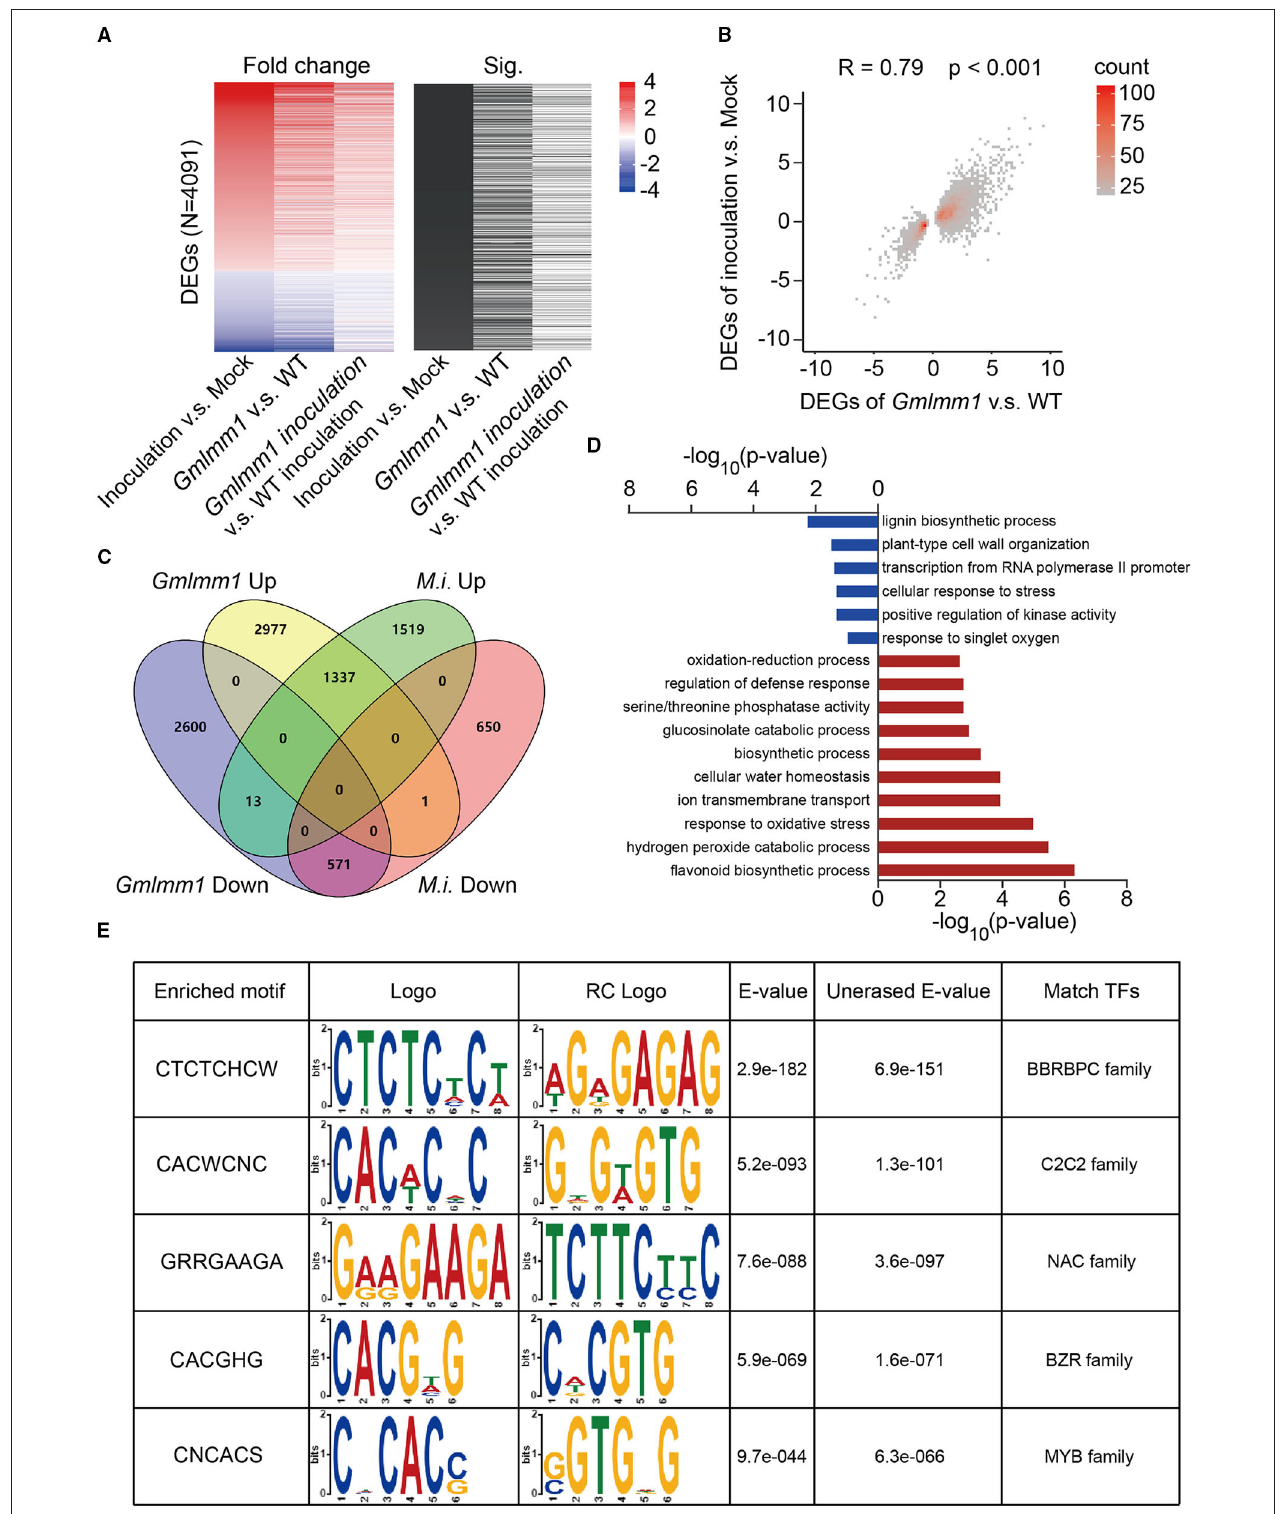
FIGURE 3 | RNA-seq assay identifies GmLMM1 -regulated genes in defense response against M. incognita . (A) Heatmap of fold changes in DEGs following M. incognita inoculation ( n = 3) or GmLMM1 mutation or the combination of both. A significant difference in p < 0.05 was observed. (B) Spearman’s correlation